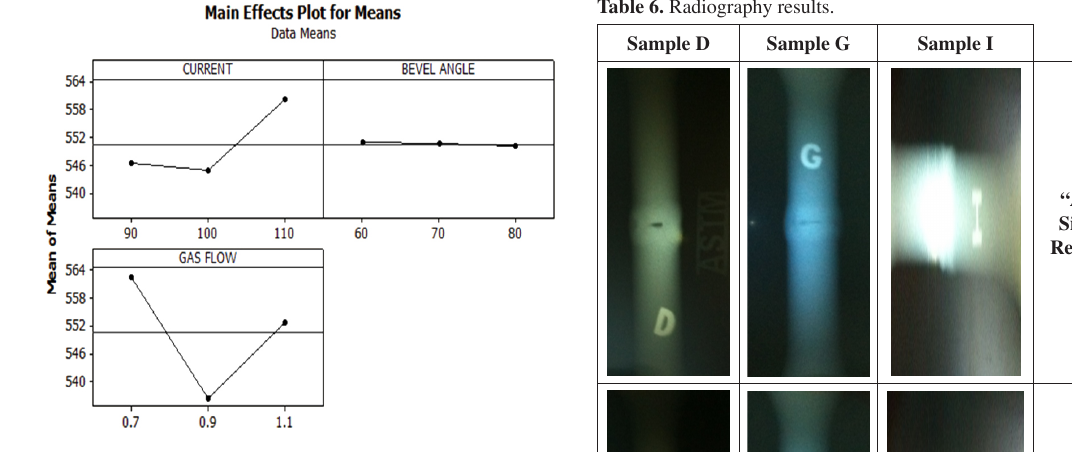
Figure 8. Main effect plot for